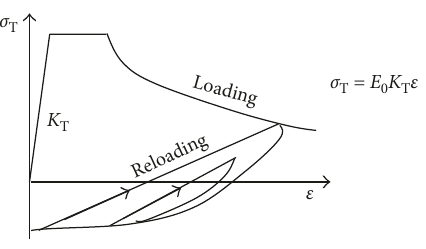
Figure 12: Tension